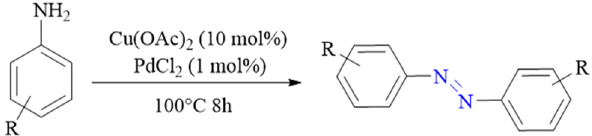
Scheme 2: The optimum reaction conditions for synthesis of azo